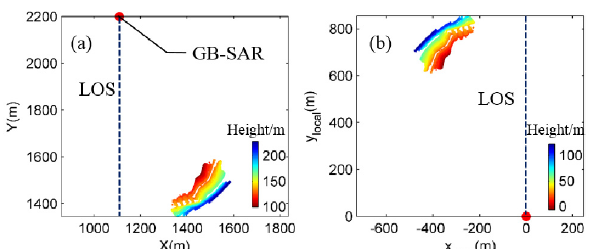
Figure 6. Projection calculation of 3D terrain coordinate of slope point cloud to radar imaging plane.